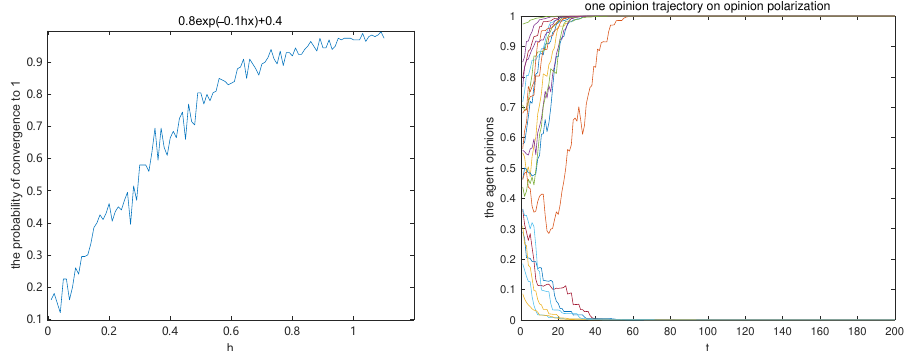
Figure 1. The different opinion evolutions on the model (1), where lines of different colors mean different agent opinion trajectories. ( left ) The opinion consensus phenomenon; ( right ) The opinion polarization